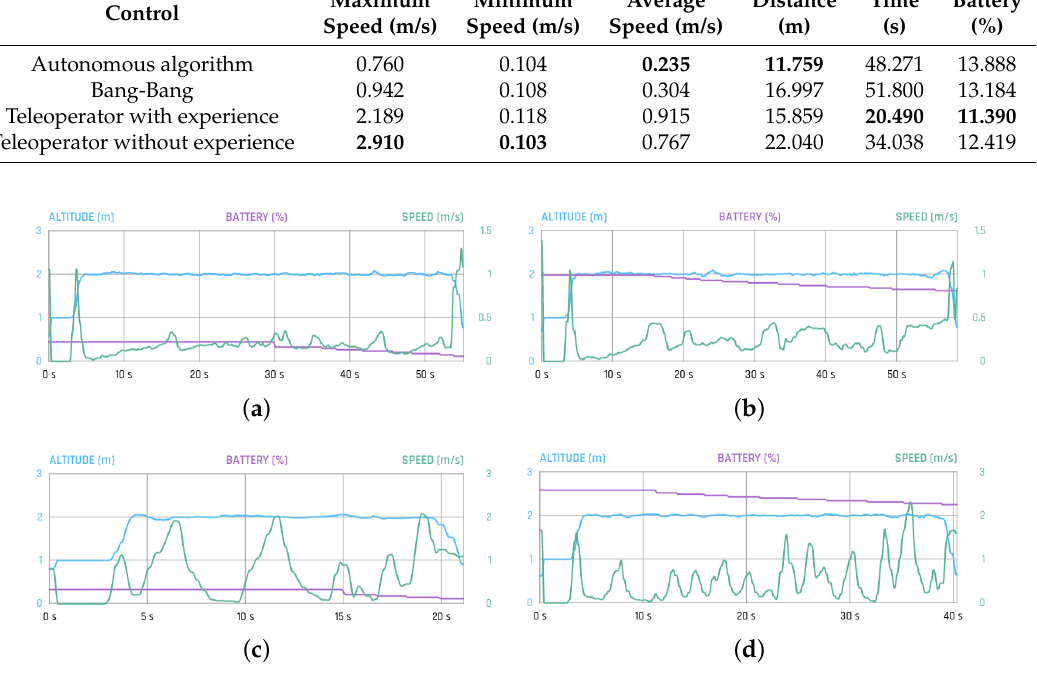
Figure 25. Results of a fixed and two mobiles obstacles. ( a ) Autonomous control; ( b ) bang-bang control ( c ) teleoperator with experience; ( d ) teleoperator without